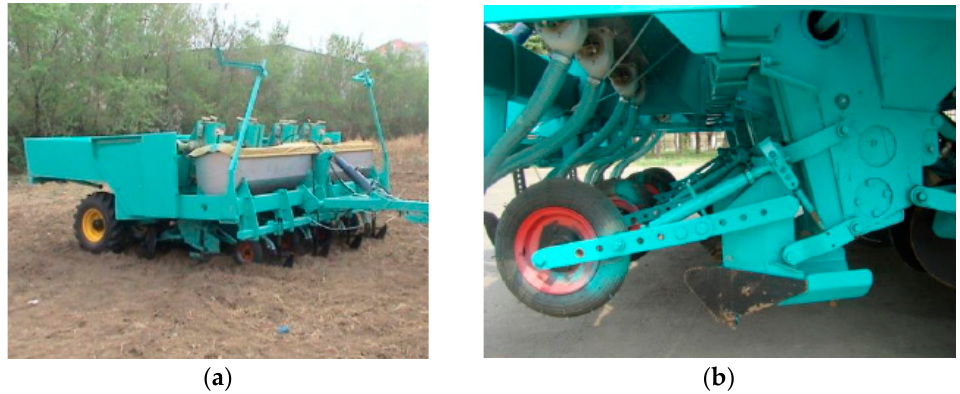
Figure 28. Two views of the 2CMW-4B planter and the depth control device. ( a ) Operation process of the device; ( b ) Structure of ditching and seeding device. Reprinted with permission from ref. [99]. Copyright 2019 Shandong University of Technology.